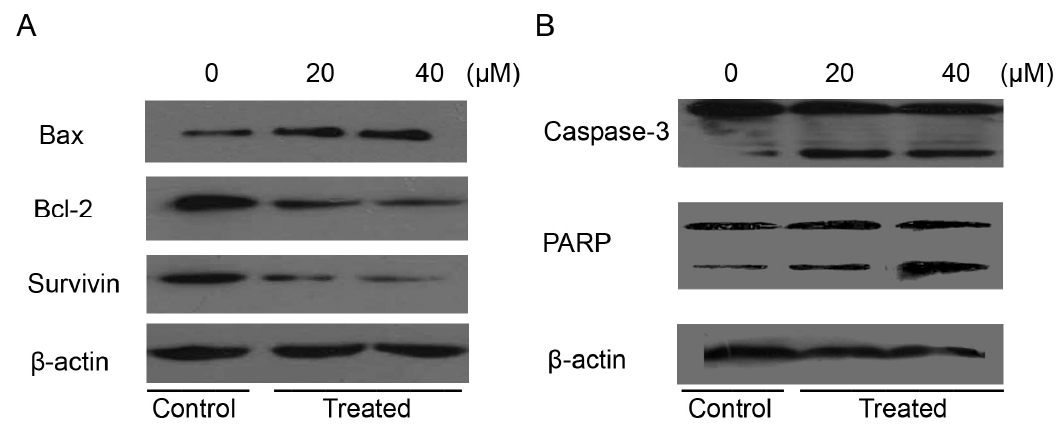
Figure 8. The effect of isoalantolactone on the expression of major apoptosis regulatory proteins. PC3 cells were exposed to 20 and 40 µM of isoalantolactone for specified time intervals. Equal amounts of lysate protein were subjected to gel electrophoresis. ( A , B ) Expression levels of Bax, Bcl-2, survivin, caspase-3 and PARP were monitored by western blot assay. β -actin was used as loading control. Data are representative of three independent experiments with similar